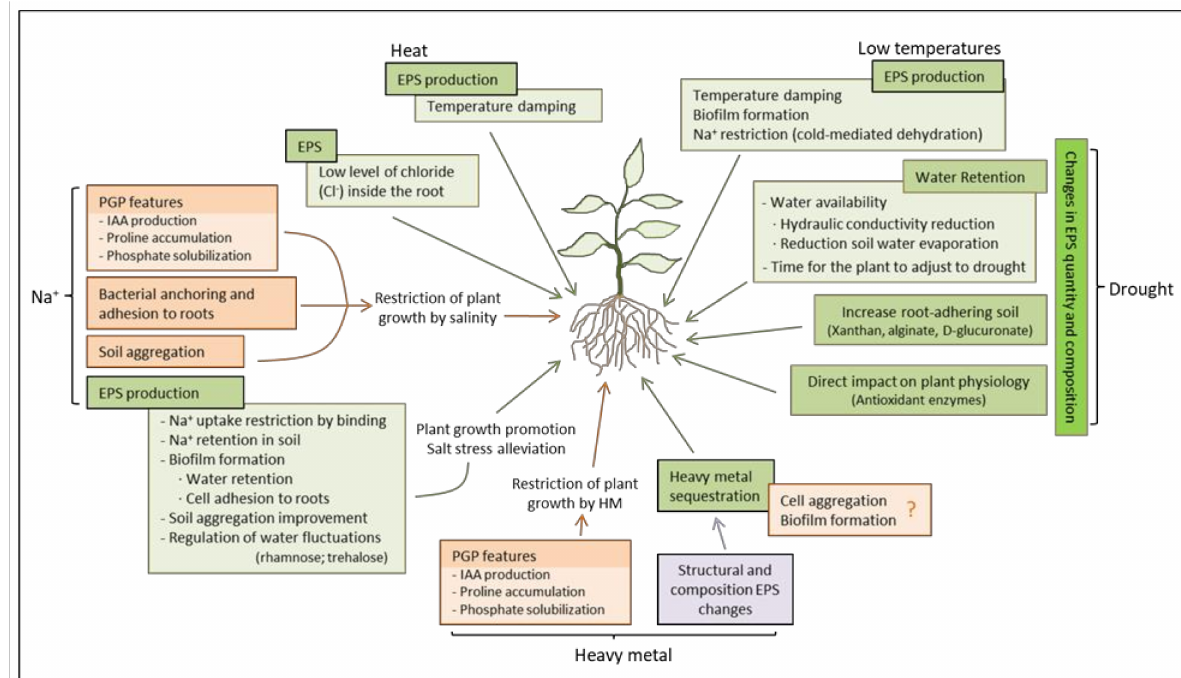
Figure 1. Microbial exopolysaccharides assisted mechanisms to alleviate abiotic stresses in plants. EPS can alleviate sodium-mediated salinity, restricting Na+ uptake by plant roots, improving soil aggregation, regulating water fluctuations, and favoring